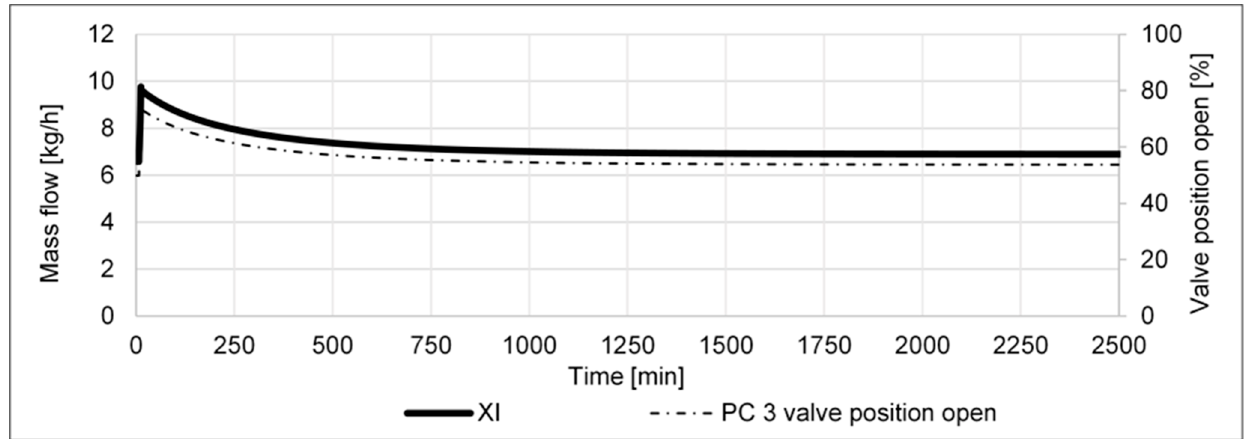
Figure 18 . Recycle mass fl ow and position of the recycle valve (left and right vertical axis) of scenario (g).